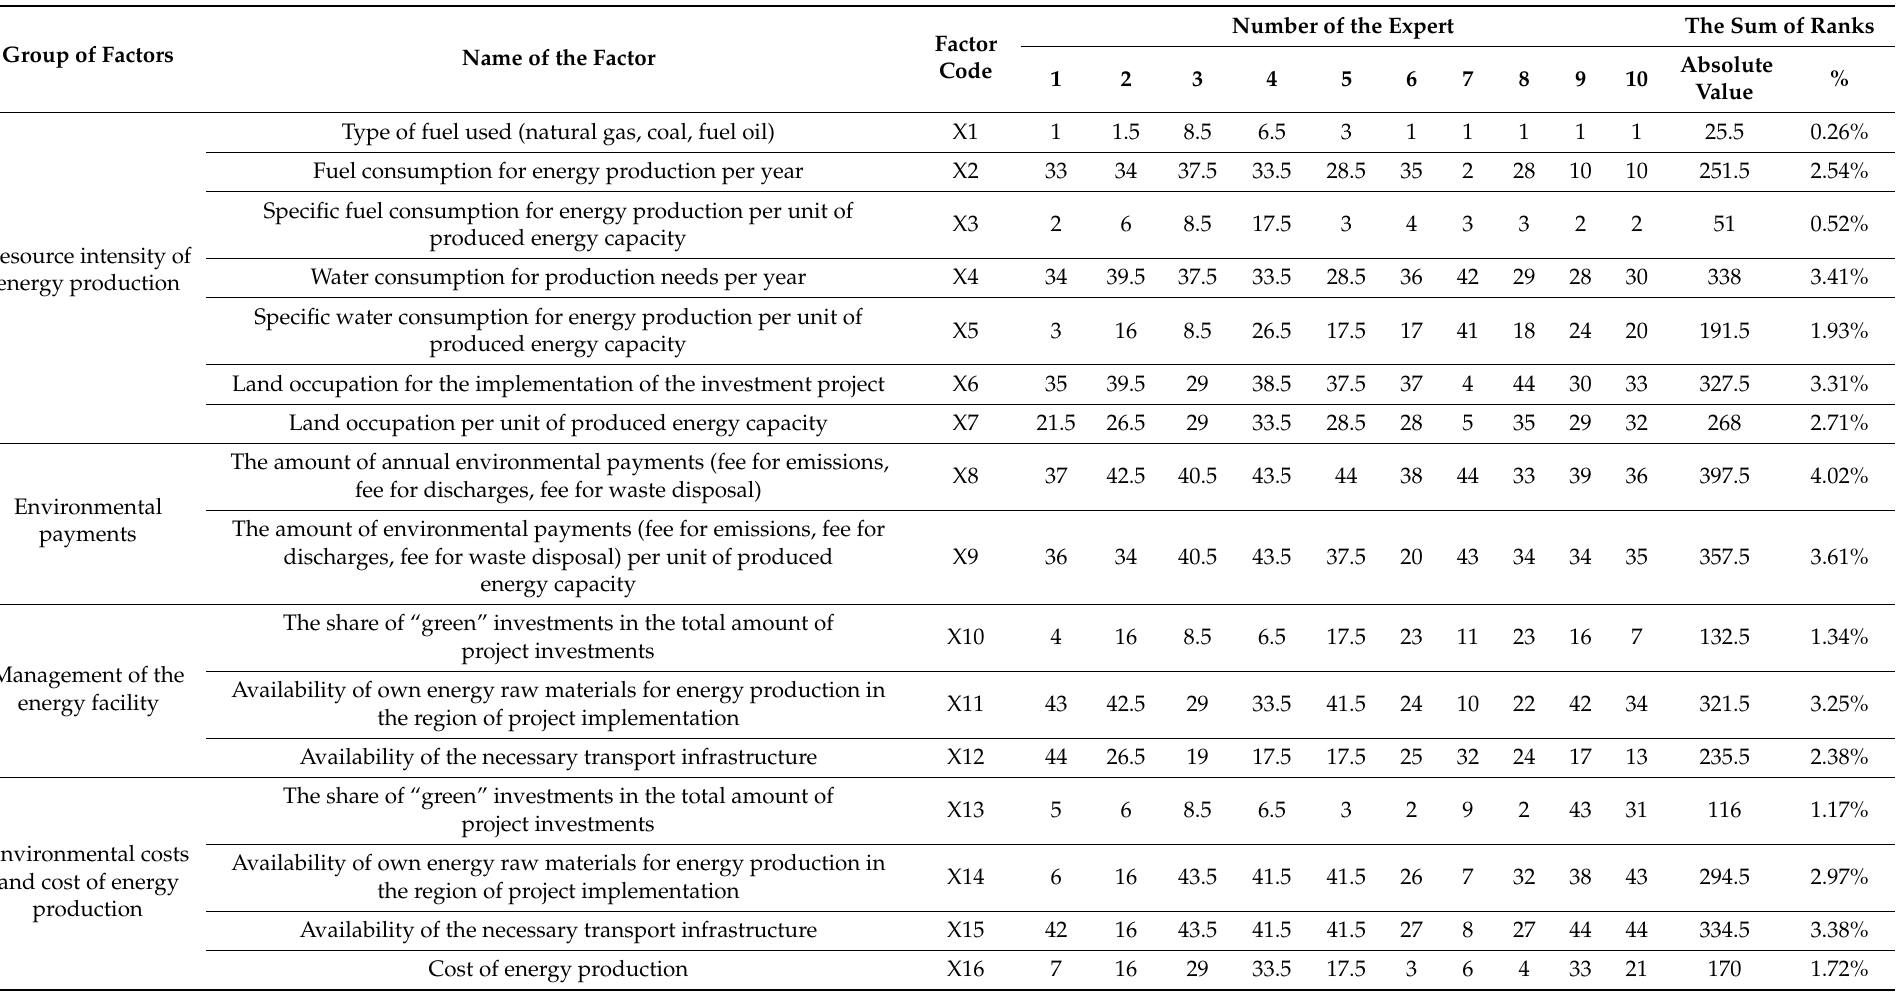
Table A1. Results of a priori ranking of